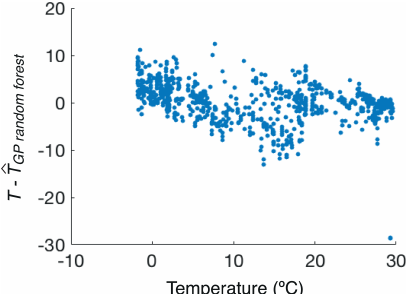
Figure 4. The error of a random forest predictor as a function of the true